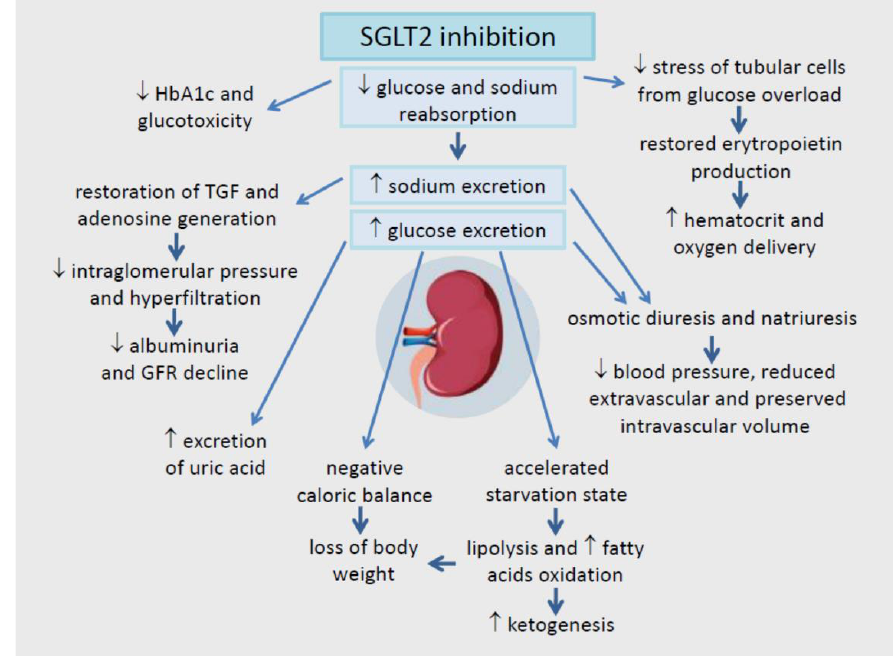
Figure 1. Summary of cardiorenal protective effects driven by inhibition of SGLT2.